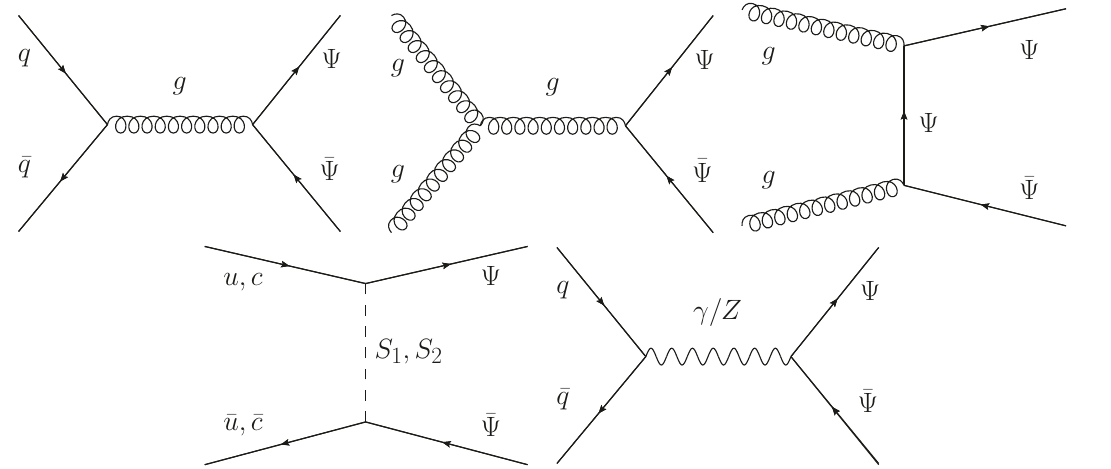
Figure 5. Representative Feynman diagrams for leading order partonic processes contributing VLQ pair production pp → Ψ¯Ψ at